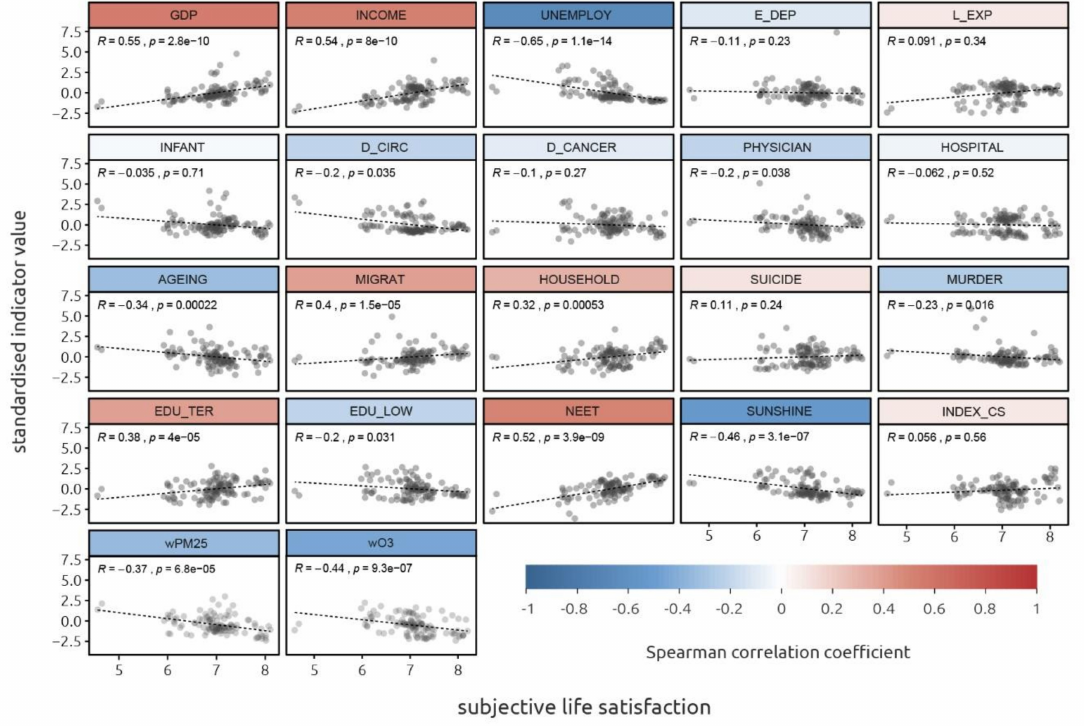
Figure 3. Correlation between the standardised values of the objective indicators and subjective life